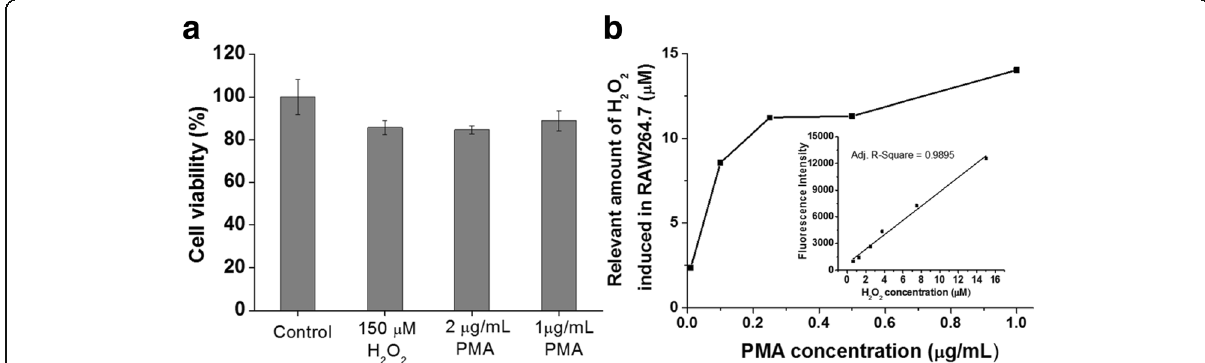
Fig. 4 a WST-1 assay of RAW 264.7 macrophages after treatments of exogenous H 2 O 2 or stimulation with phorbol 12-myristate 13-acetate (PMA) for 1 h. b Detection of the concentration of H 2 O 2 endogenously produced by RAW264.7 macrophages under various concentrations of the PMA stimulant in the presence of horseradish peroxidase-encapsulated hollow silica nanospheres (HRP@HSNs) and dihydrorhodamine 123 (DHR123). Inset: a calibration curve obtained from the external standards of H 2 O 2 mixed with HRP@HSNs and